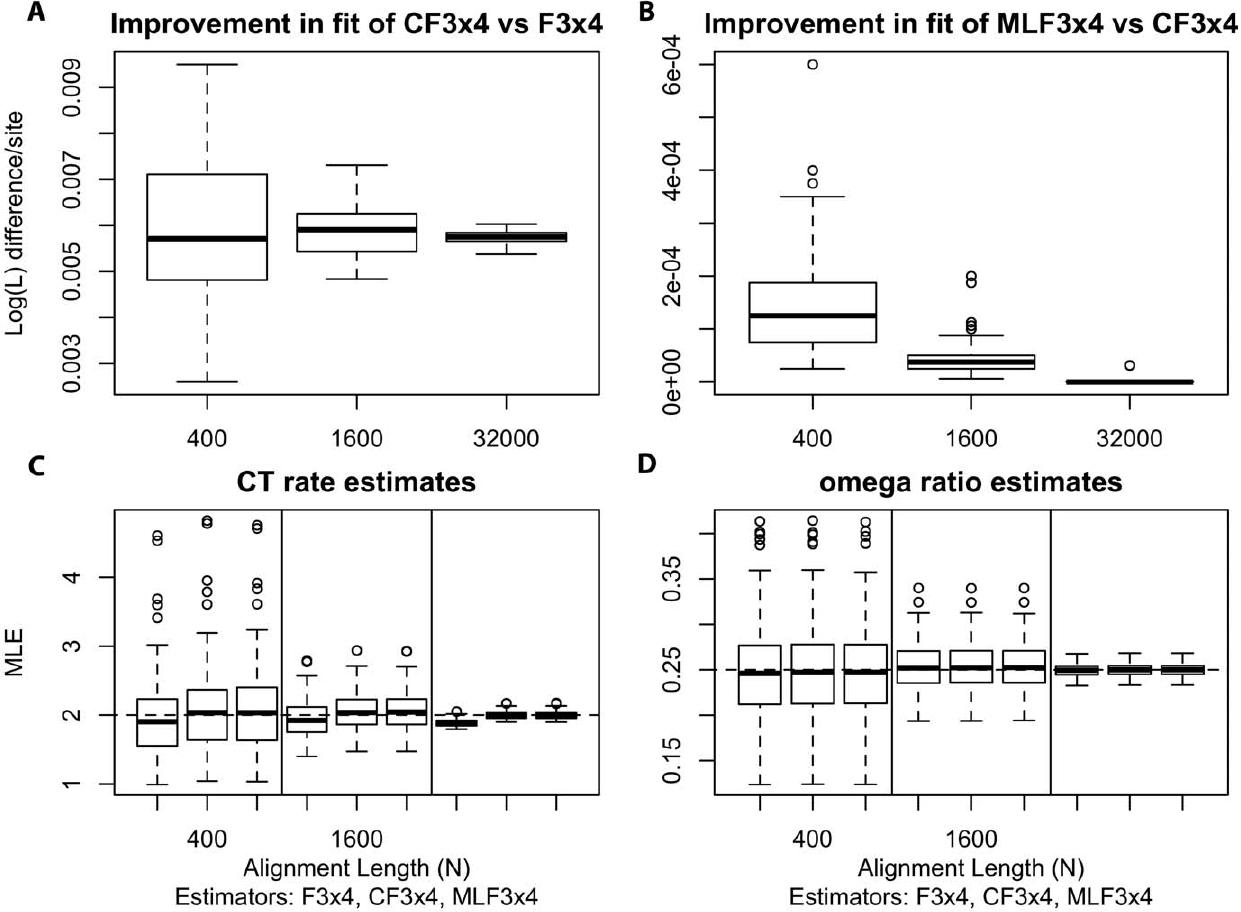
Figure 2. Comparison of frequency parameterizations fitted to simulated alignments. The top row (A,B) shows the comparison of log L scores on simulated data obtained with different corrected frequency estimates; C) Bias in the estimate of the substitution rate h CT ~ 2 : 0 in near- asymptotic regime ( L ~ 32000 ) is apparent under F 3 | 4 , but does not exist for the other two estimators; D) variance of the CF 3 | 4 estimate for h CT is reduced with increasing sample size.